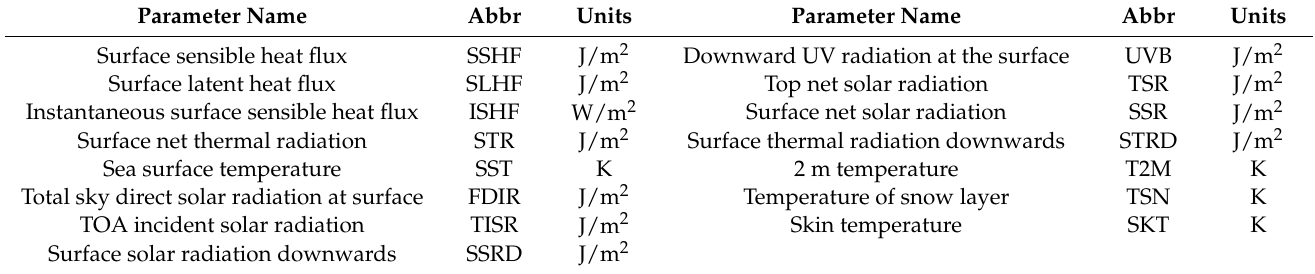
Table 2. List of candidate parameters.